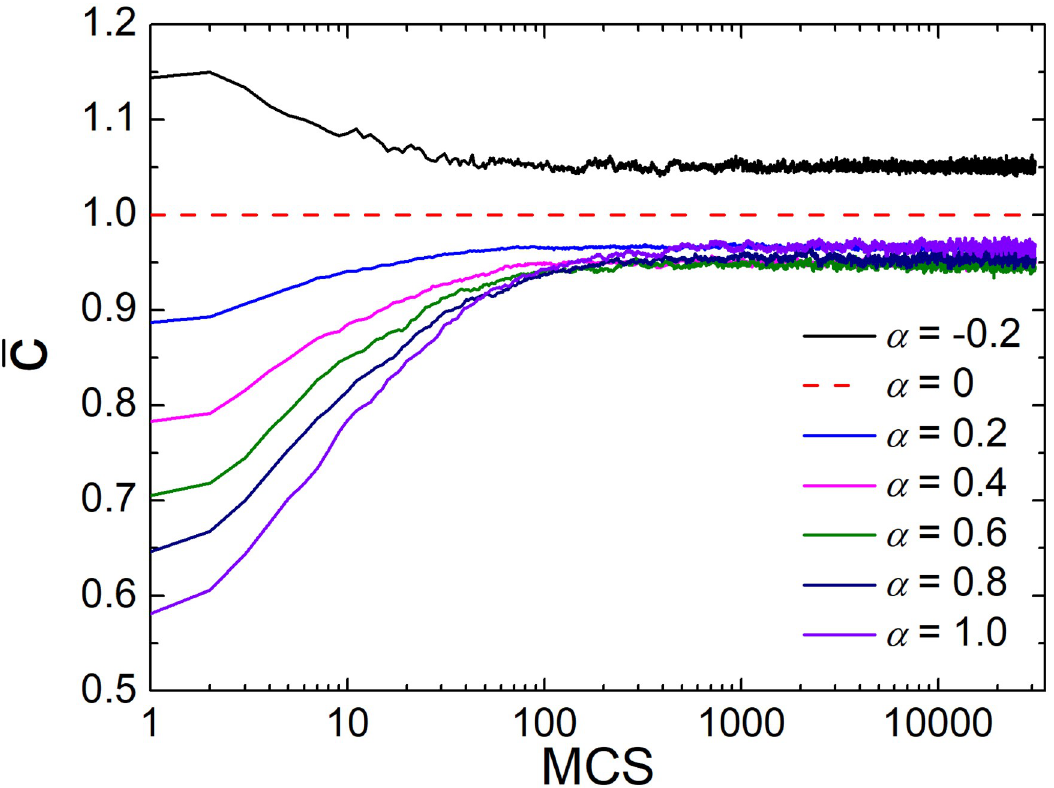
Fig 5. Average investment of cooperators for the different values of α as r = 4 and M = 1. Investment preference changes the investment behaviors effectively. At the same time, investment will keep fluctuation when games reach the equilibrium.